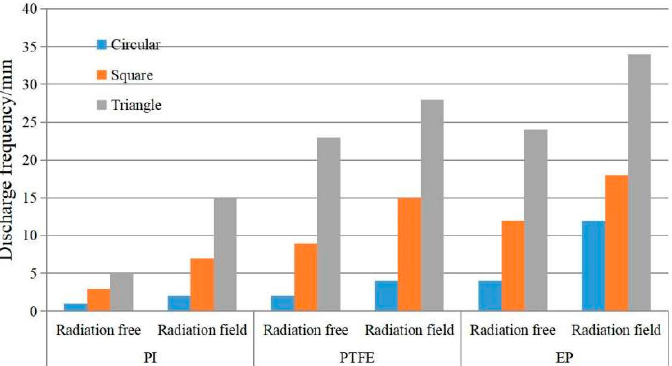
Figure 13. Comparison of discharge characteristics of dielectric materials coated ground electrodes of different shapes with or without external field irradiation.